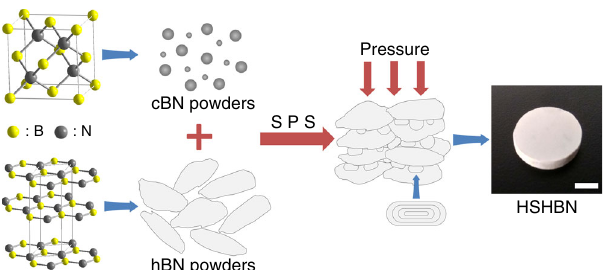
Fig. 1 Schematic illustration of the HSHBN consolidation process. The scale bar represents 5